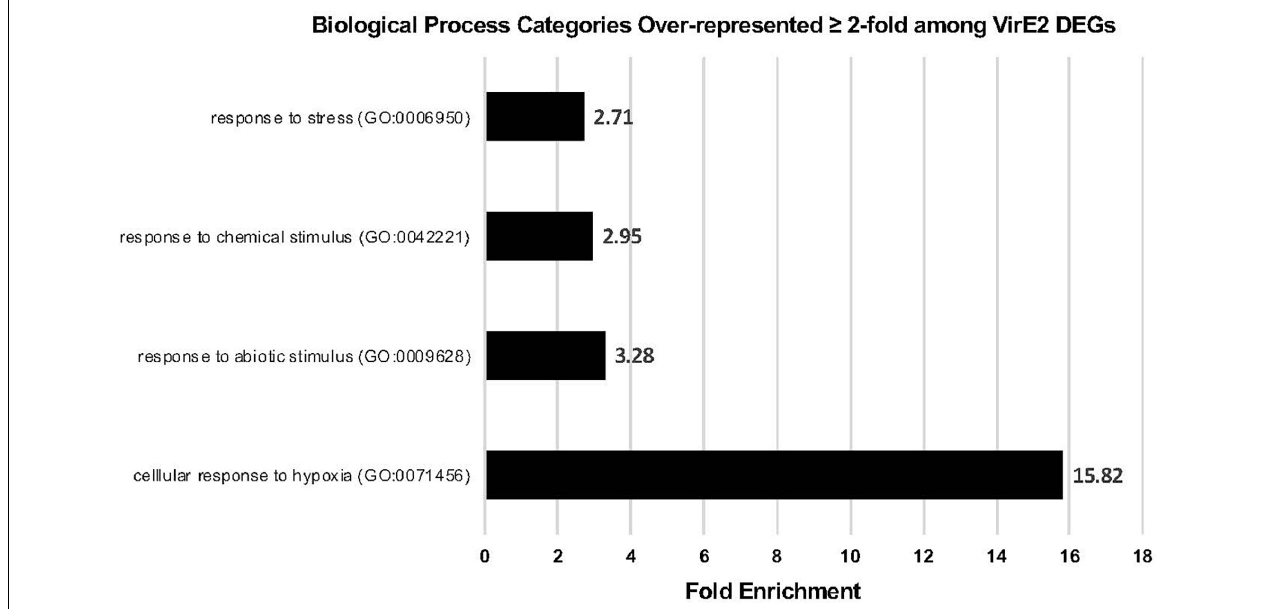
FIGURE 4 | Gene Ontology (GO) Enrichment Analysis of VirE2 differentially expressed genes. GO biological processes of over-represented gene categories for VirE2 differentially expressed genes at all time points. Displayed are results only with a false discovery rate (FDR) <